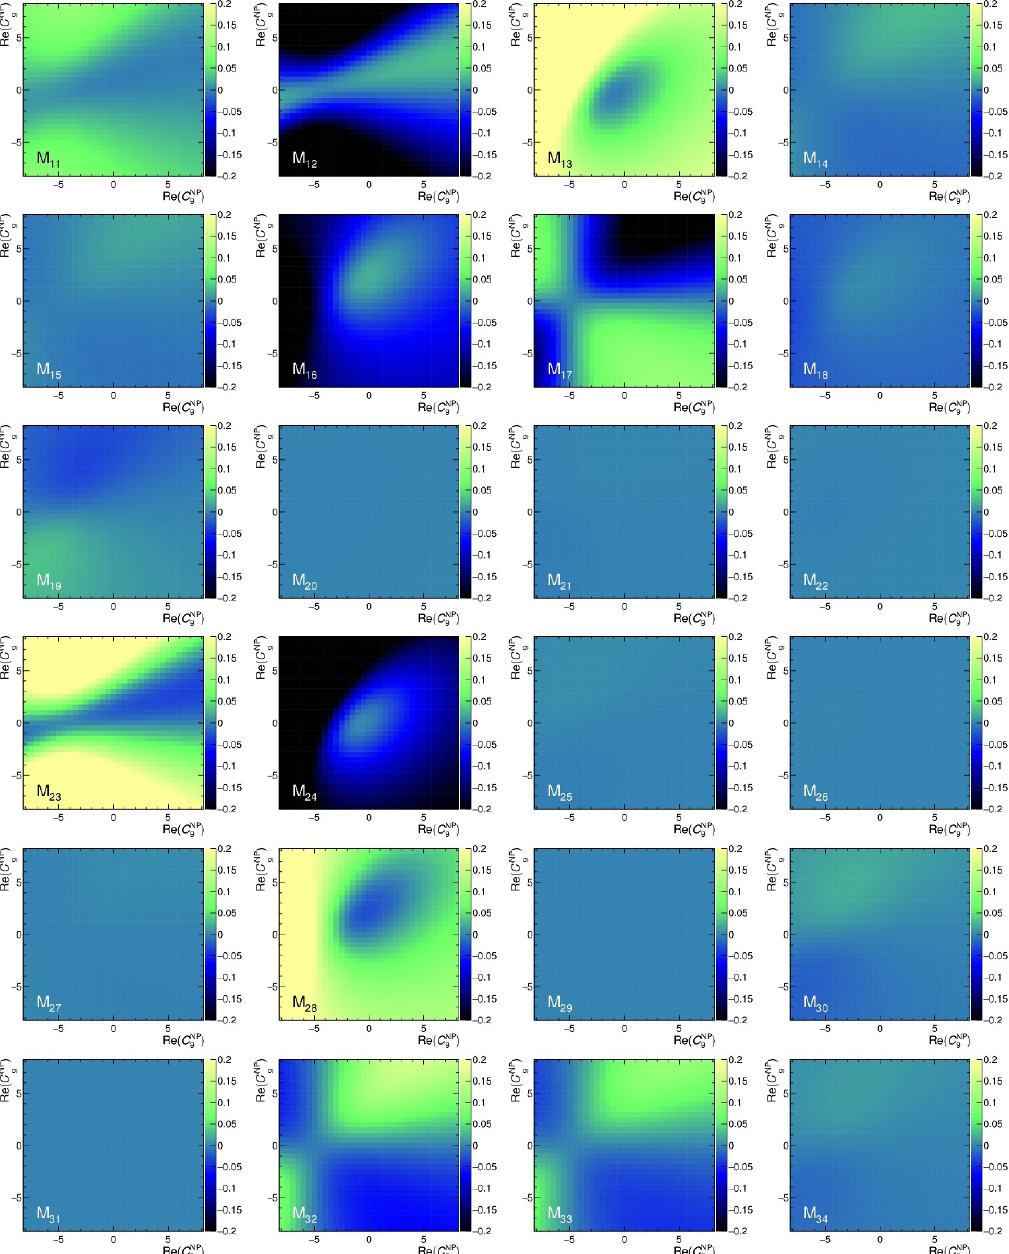
+ (cid:22) (cid:0) decay b ! (cid:3) (cid:22) = 1 is used. b